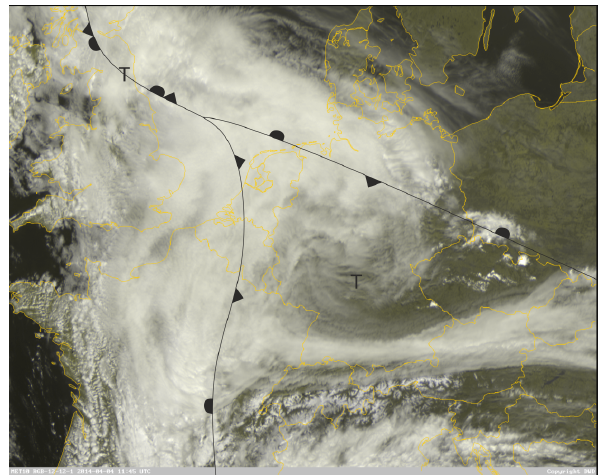
Figure 4. RGB composite of Germany and surrounding countries as observed by the Meteosat-10 satellite for 4 April 2014, 11:45UTC. Frontal zones as analyzed by DWD based on surface observations for 4 April 2014, 12:00UTC. Data source: EUMETSAT and DWD.